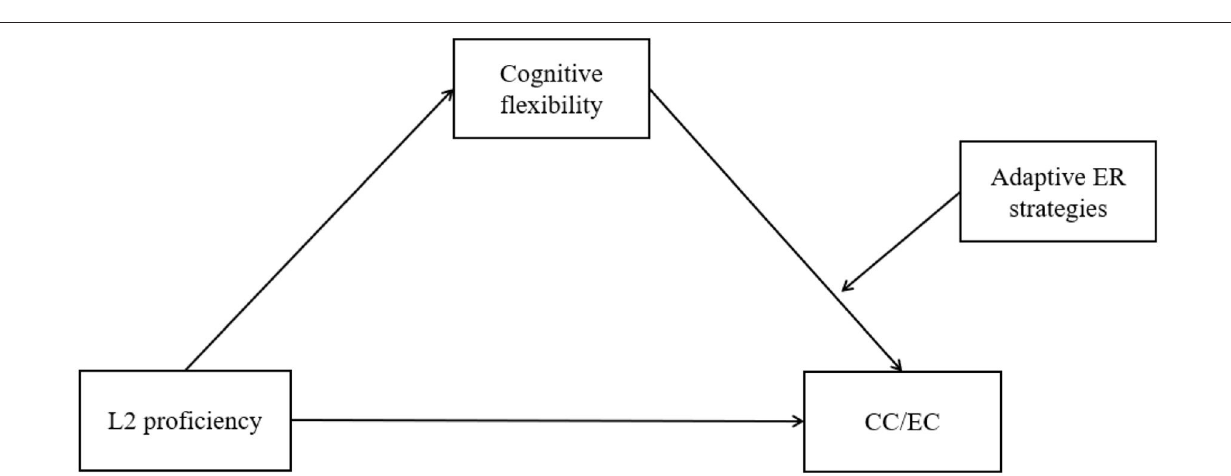
FIGURE 2 | The moderated mediation analysis using the PROCESS (Model 14) macro for